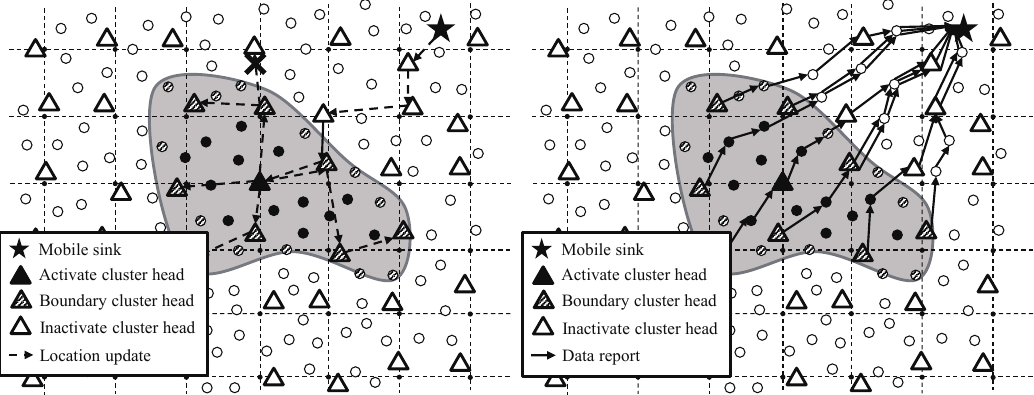
Figure 13. Location update and data report in OCOT: ( left ) Location update and ( right ) Data